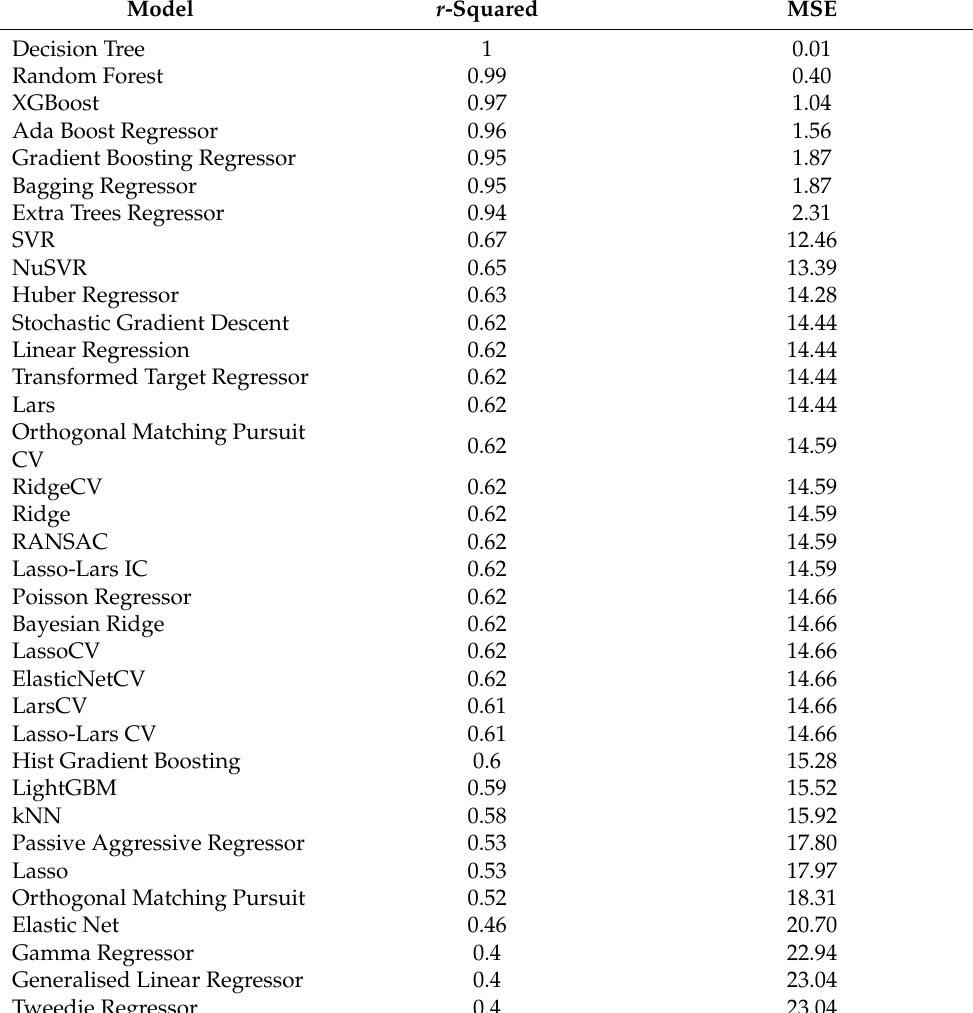
Table 2. Empirical experimental results of machine learning models in preliminary